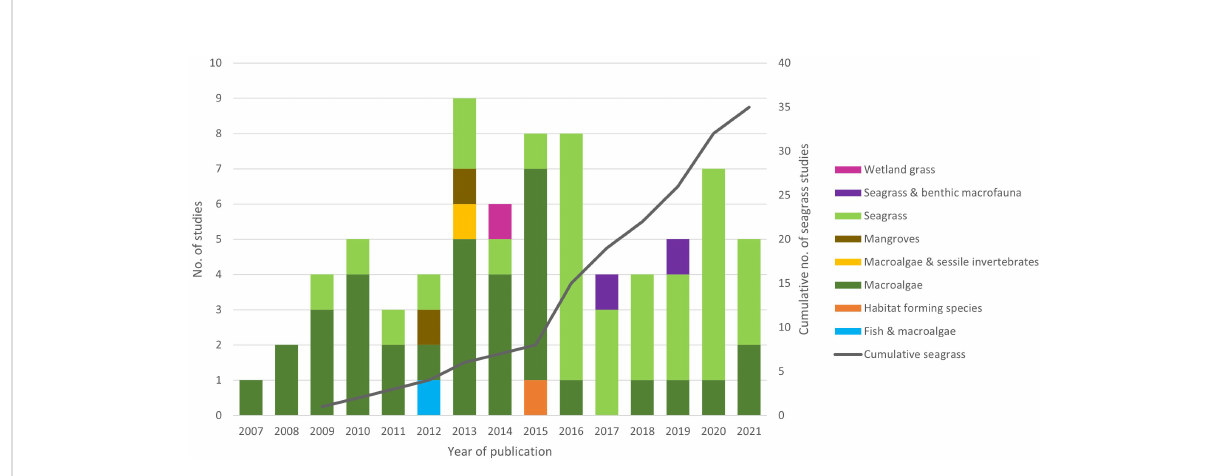
FIGURE 1 Trends in taxa used as focus within marine macrophyte HSM studies with year of publication and cumulative number of seagrass studies on secondary y